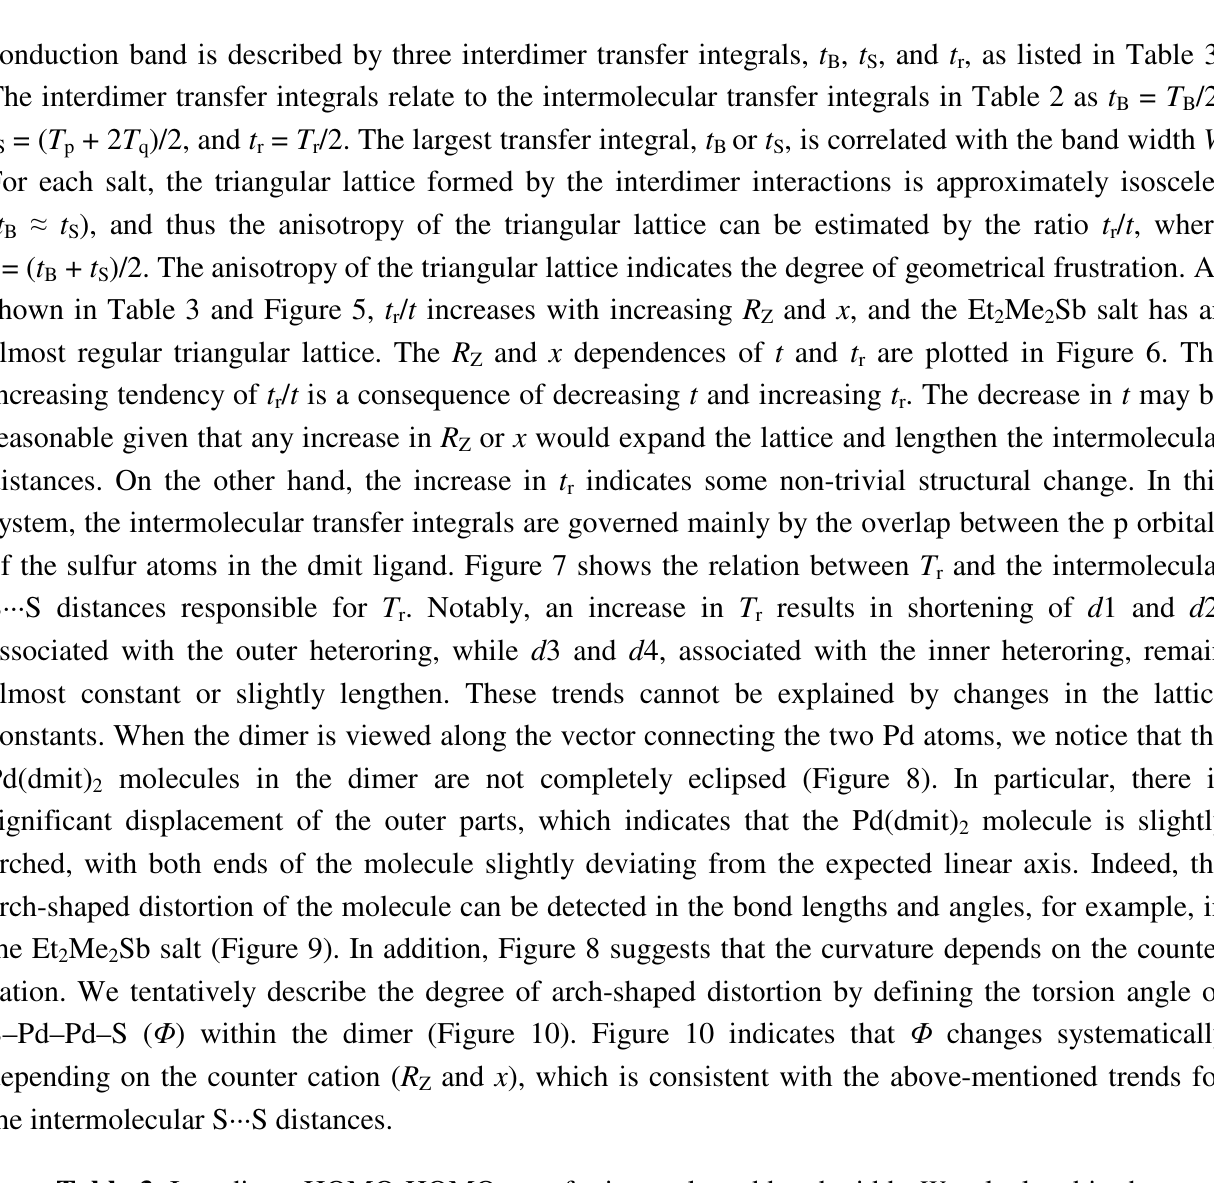
Table 3. Interdimer HOMO-HOMO transfer integrals and band width, W , calculated in the dimer model (See Figure